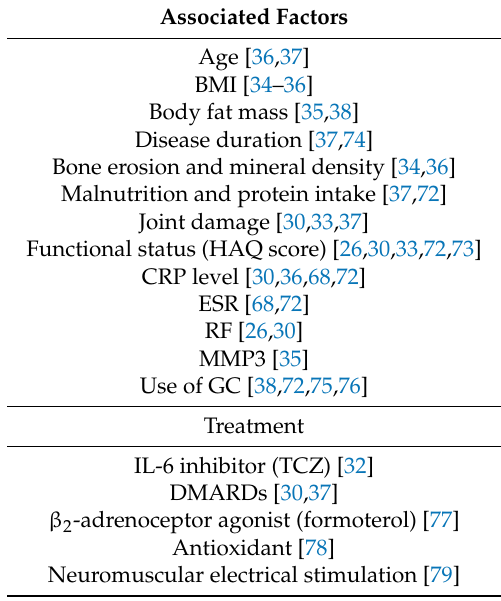
Table 2. Study Findings Related to Sarcopenia in Patients with Rheumatoid